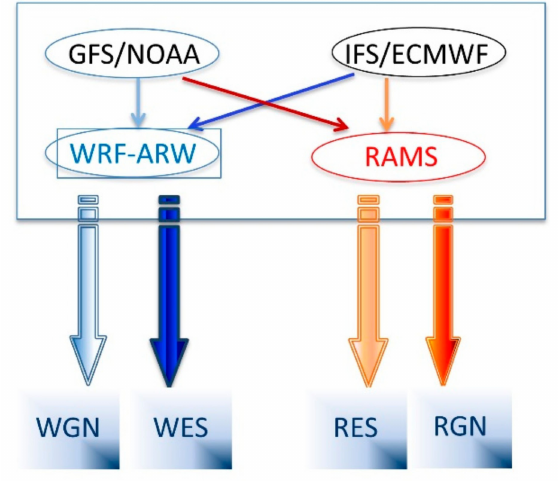
Figure 3. Scheme of the weather forecast obtained from four different model